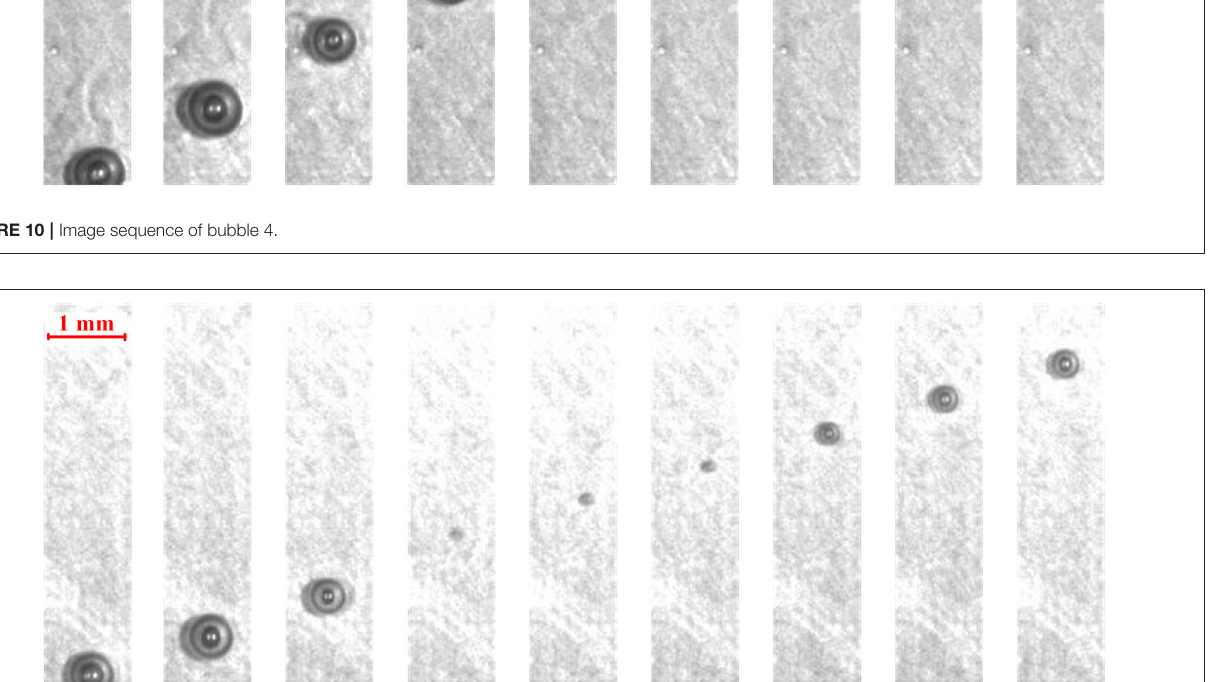
FIGURE 11 | Image sequence of bubble